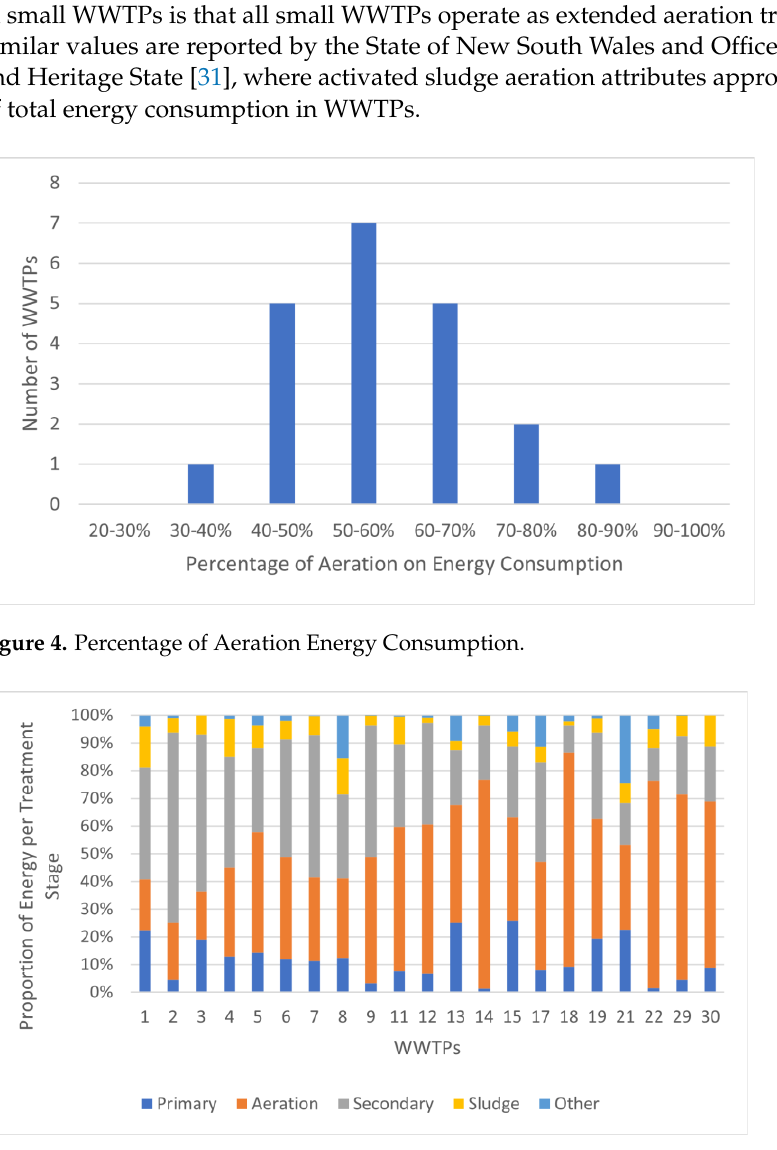
7 of 13 Figure 3. WWTP Energy Consumption by Population Served.